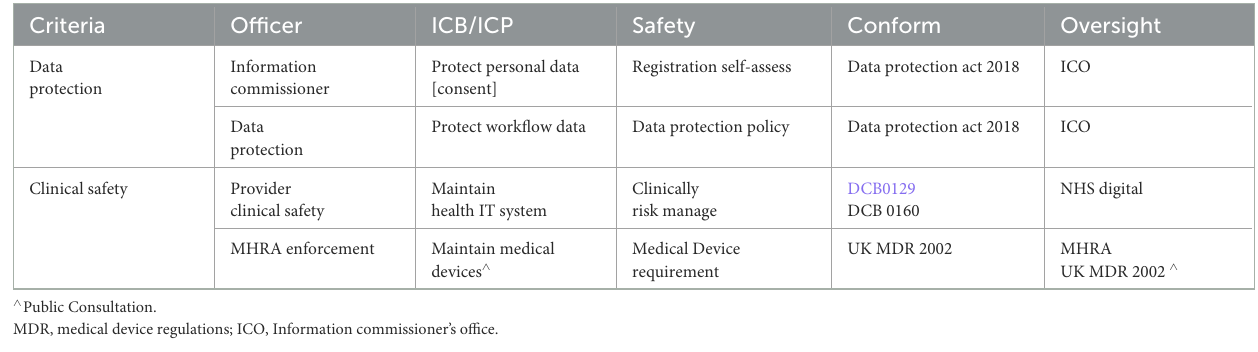
TABLE 5 Data protection and clinical safety.